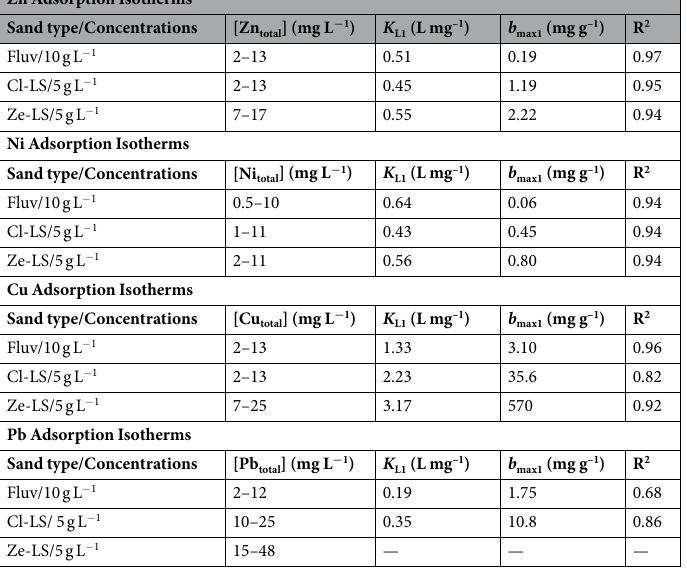
— — — Table 1. Parameters of one-site Langmuir adsorption isotherms (Eq. 1) fitted to experimental data for Zn, Ni, Cu and Pb adsorption to zeolite- (Ze-LS) and clinopyroxene-dominated lava sand (Cl-LS) and fluviatile sand (Fluv) (Fig. 4). —: Not